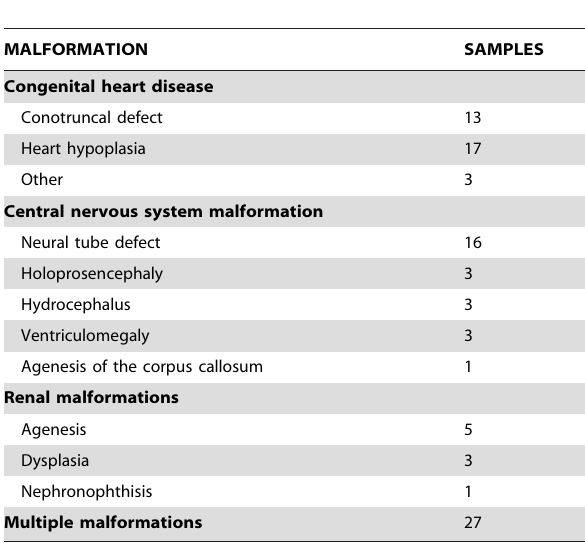
Table 1. Overview of malformations in the 95 analyzed